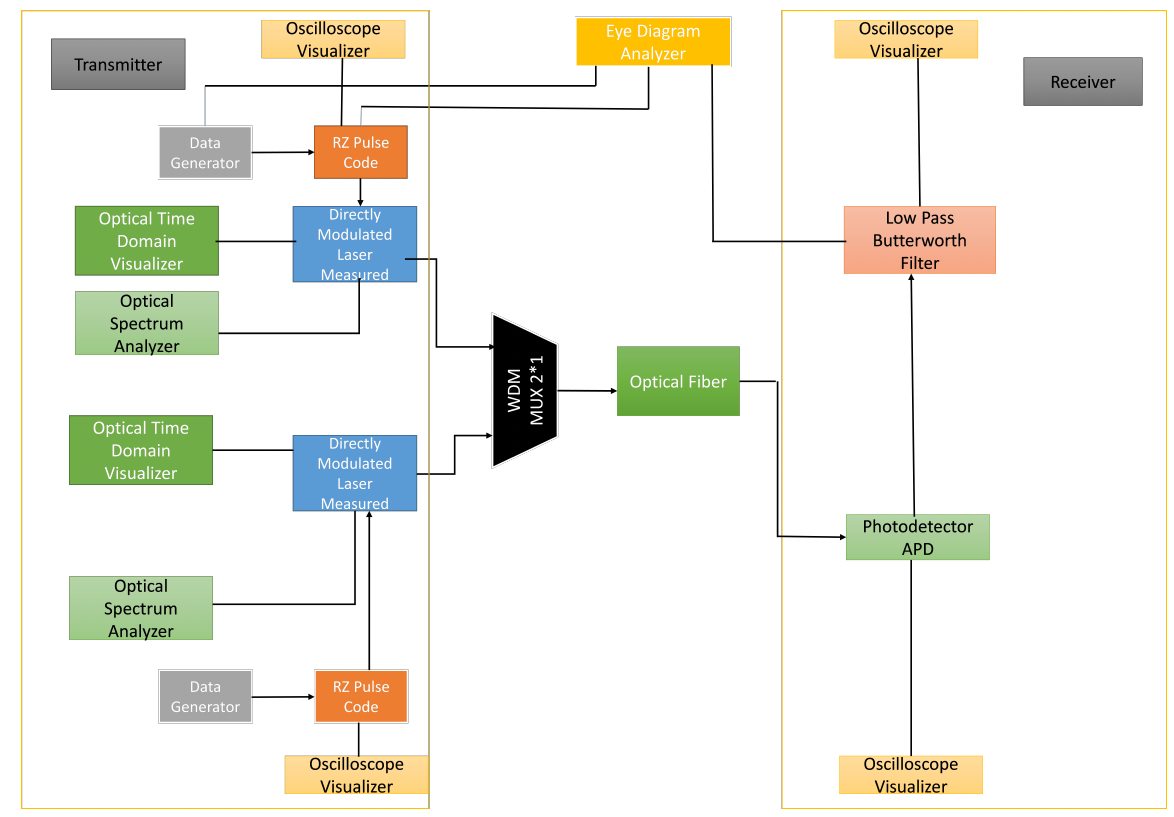
Figure 1: Simulation model used in this